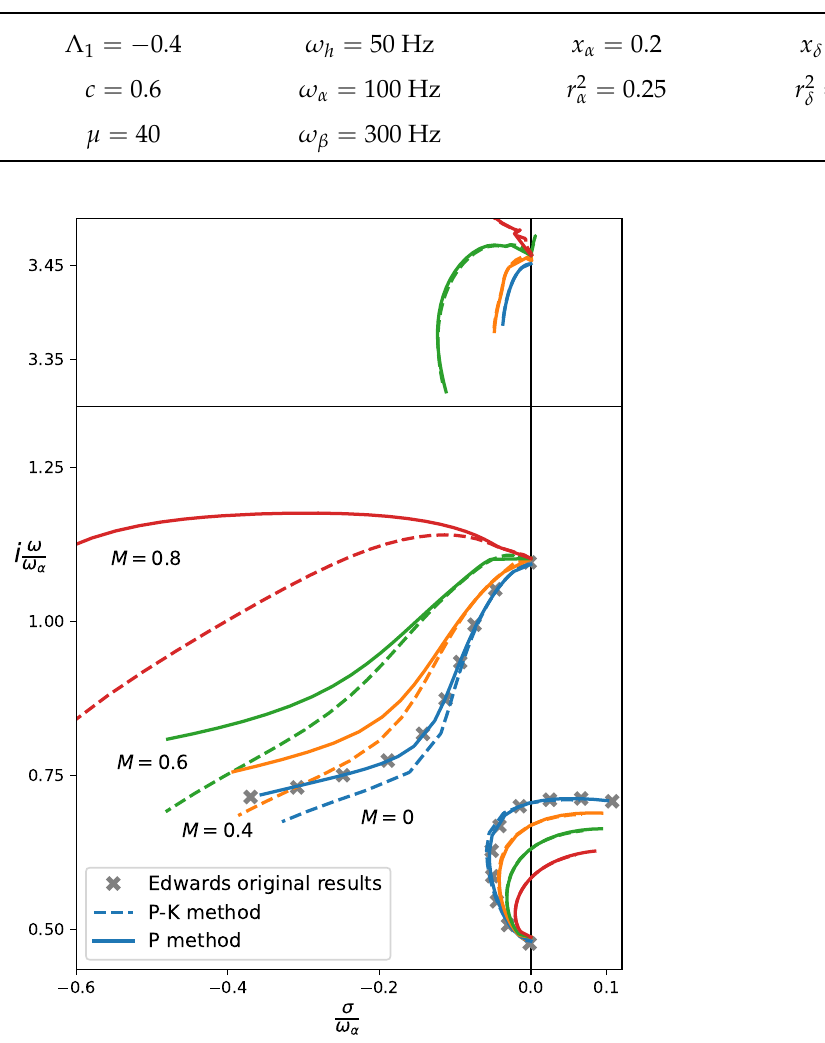
Table 1. Three DOF section parameters for a wing section in incompressible flow.